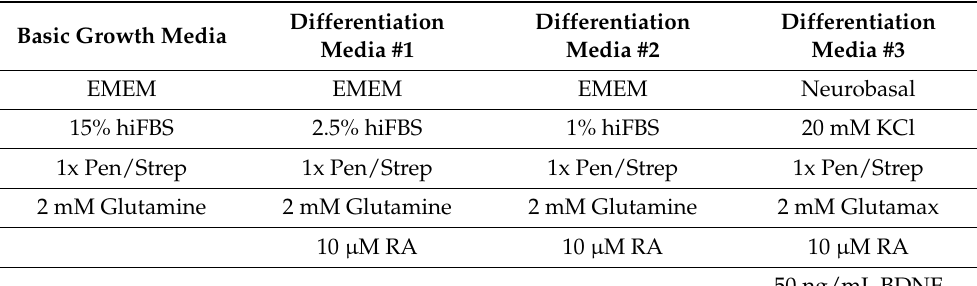
Table 2. Cell culture media for SH-SY5Y neuronal differentiation. Breakdown of different cell culture media used for SH-SY5Y differentiation